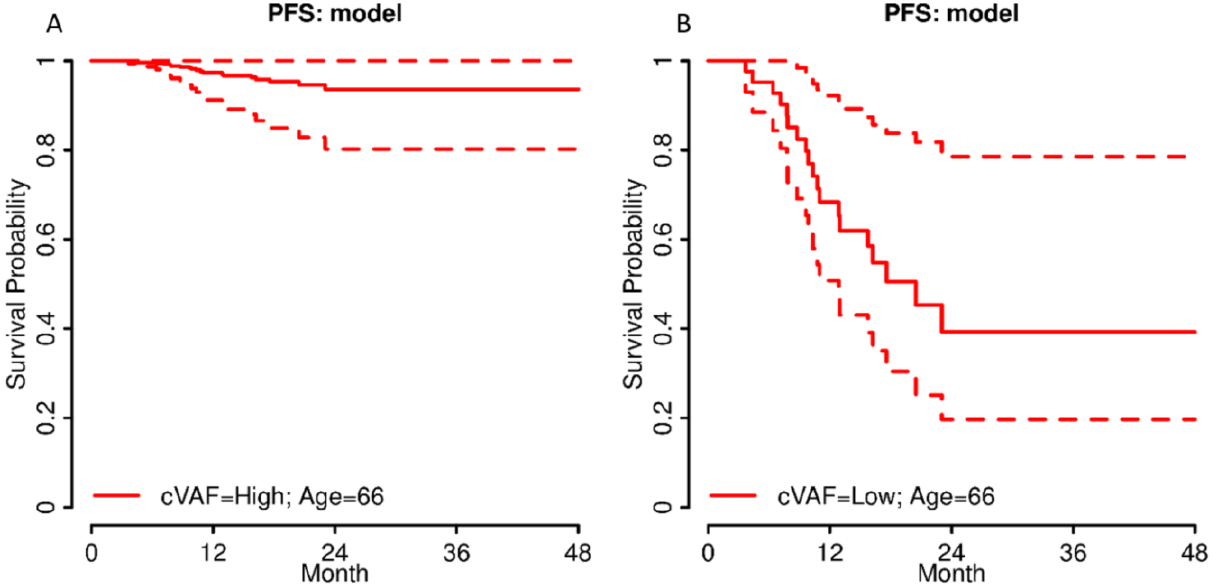
Figure 6. Survival curves with 95% confidence intervals according to the multiple Cox regression model from Table 3 for single patients with either a ( A ) high or ( B ) low cVAF (Table 3) and an age of 66 years. 66